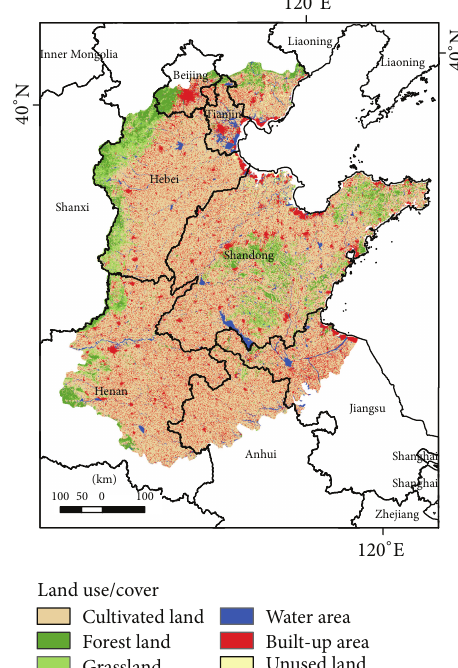
Figure 2: Land use pattern of the North China Plain in the year